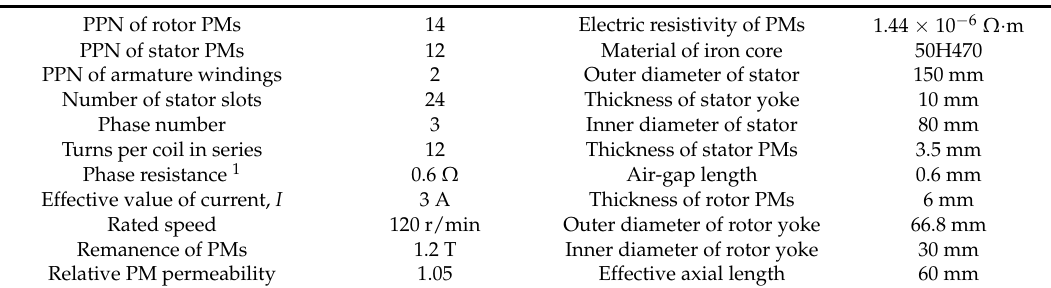
Table 5. Key parameters of the proposed machine.